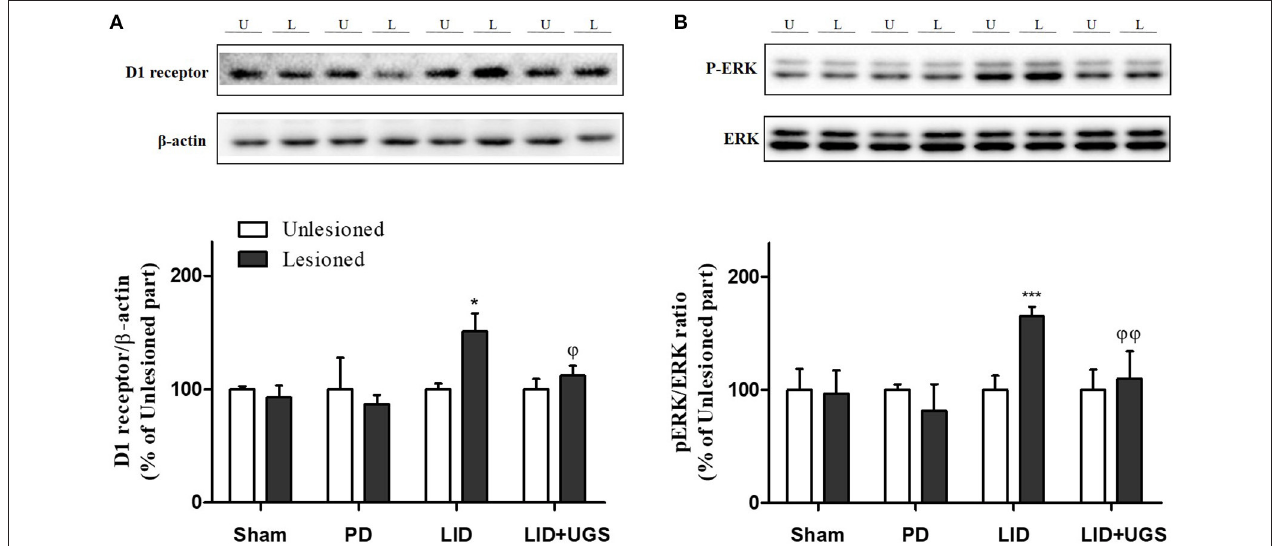
FIGURE 8 | UGS reduced the expression of D1R and the phosphorylation of ERK after development of LID. Representative band images and the quantification data of D1R (A) and p-ERK (B) for western blot analysis. Values of quantification data are given as the mean ± S.E.M. ( N = 6). The significance of differences was analyzed by one-way ANOVA followed by Bonferroni’s Multiple Comparison Test: * p < 0.05 and *** p < 0.001; mean values were significantly different from the unlesioned part of each group. φ p < 0.05 and φφ p < 0.01; mean values were significantly different from the LID group.